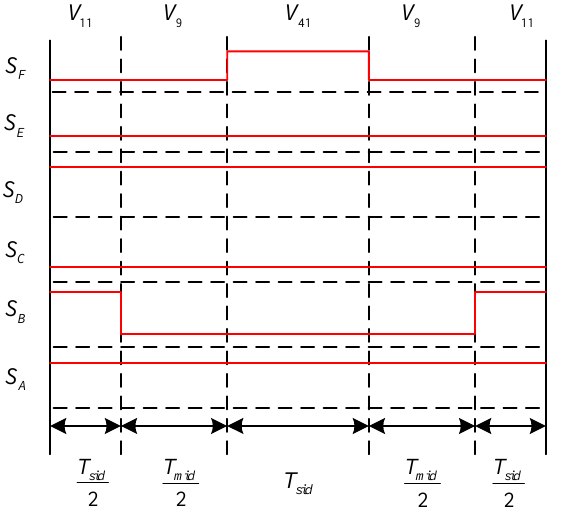
Figure 15. Switching sequence when M 1 is synthesized with constant torque response speed.